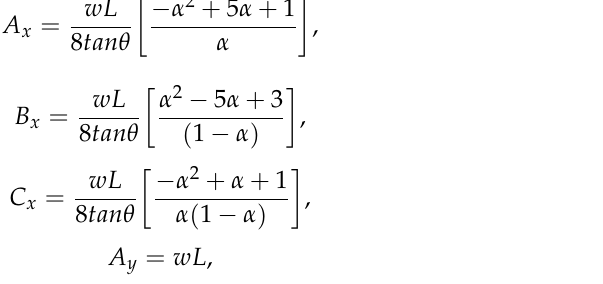
Figure 13. Details of Middle bar (all dimensions are in mm, HSS section).